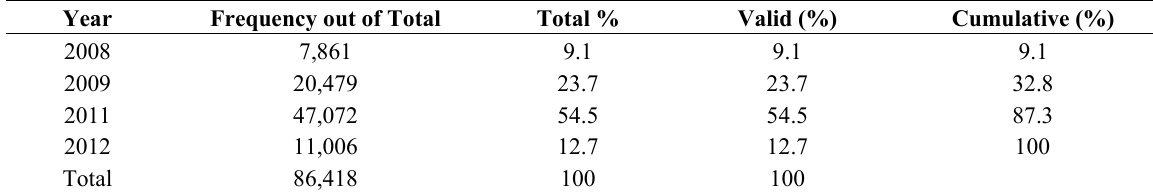
Table 2. Meteorological variables and their profiles of cleaned data used to model and predict gusts.